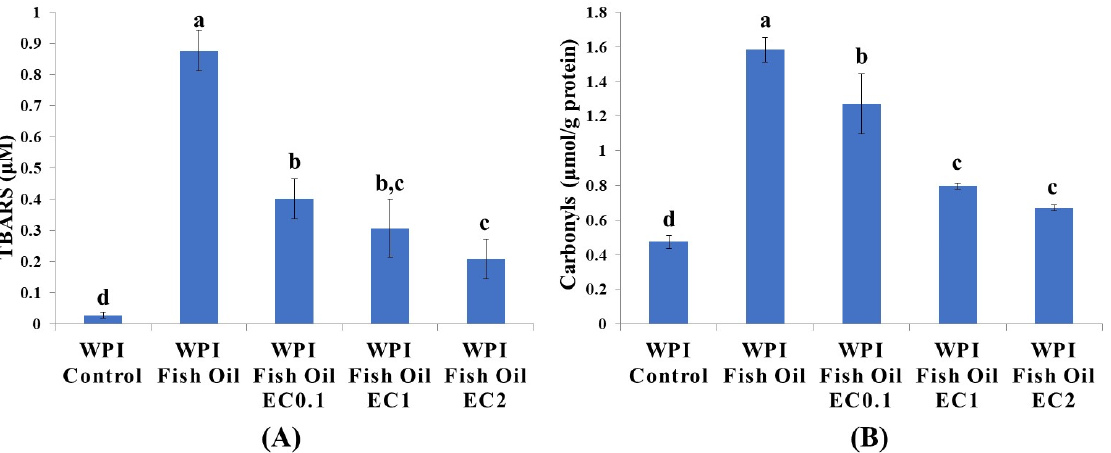
Figure 1. TBARS formation ( A ) and degree of protein carbonylation ( B ) in fish oil enriched WPI emulsions incubated at 25 °C for 24 h in the absence or presence of EC (0.1~2 mM). Means ( n = 3) of groups with no common letter (a–d) differ significantly ( p < 0.05).